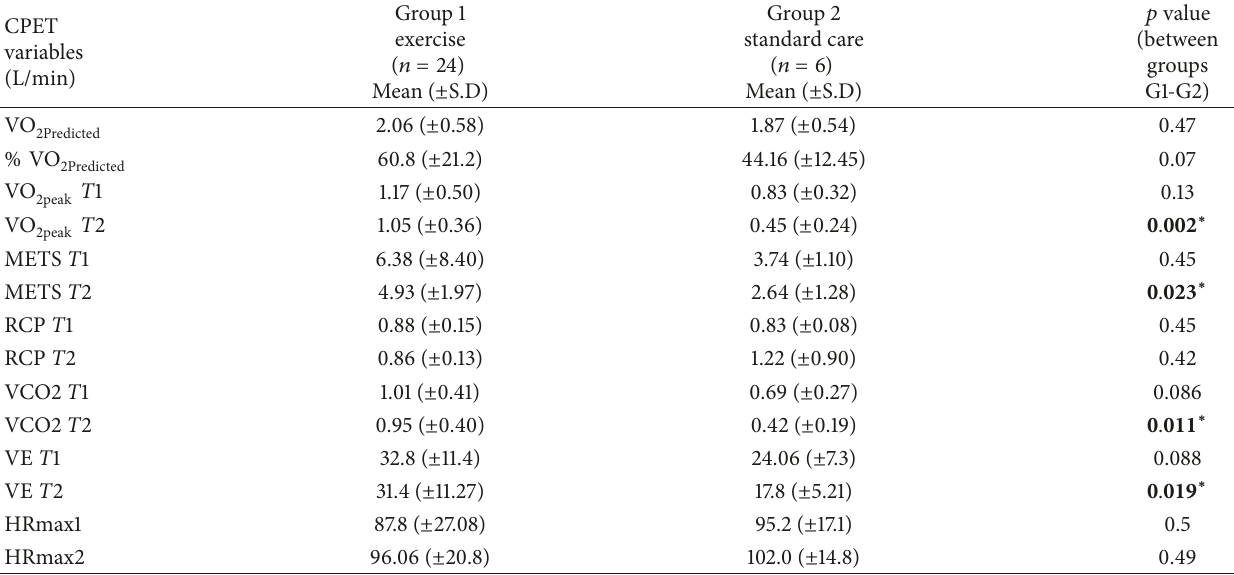
Table 3: Cardiopulmonary exercise testing measurements on the peak of effort. 𝑇 -test.